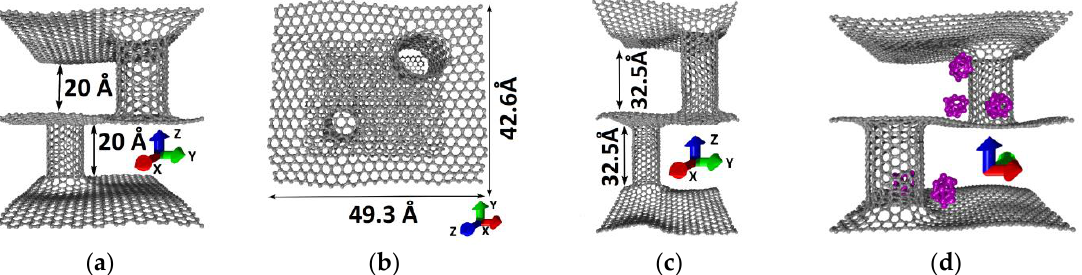
Figure 1. Pillared graphene: ( a ) supercell of model I—with short tube; ( b ) view from above; ( c ) supercell of model II—with long tube; ( d ) supercell of model I with silicon clusters Si16 (purple color).